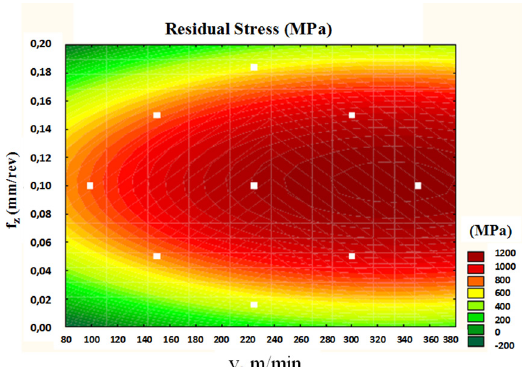
x v ) for the residual stress adopting z c